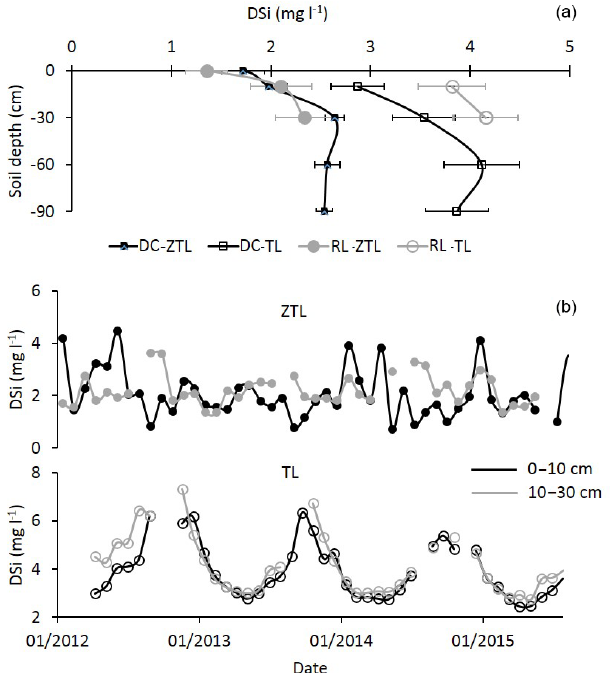
Figure 4. (a) Mean DSi concentration over 4 years (January 2012 to December 2015) in zero-tension lysimeters (ZTL) and tension lysimeters (TL) at different soil depths (0–10, 10–30, 30–60 and 60–90cm) in plots DC and RL. For each soil type and depth, values with an asterisk are significantly different according to a Mann– Whitney U test at the threshold P value level of 0.05 (solution- type effect, ZTL vs. TL). (b) Seasonal dynamics over 4 years (Jan- uary 2012 to December 2015) of DSi concentrations in ZTL and TL in the 0–10cm and 10–30cm soil layers of plot